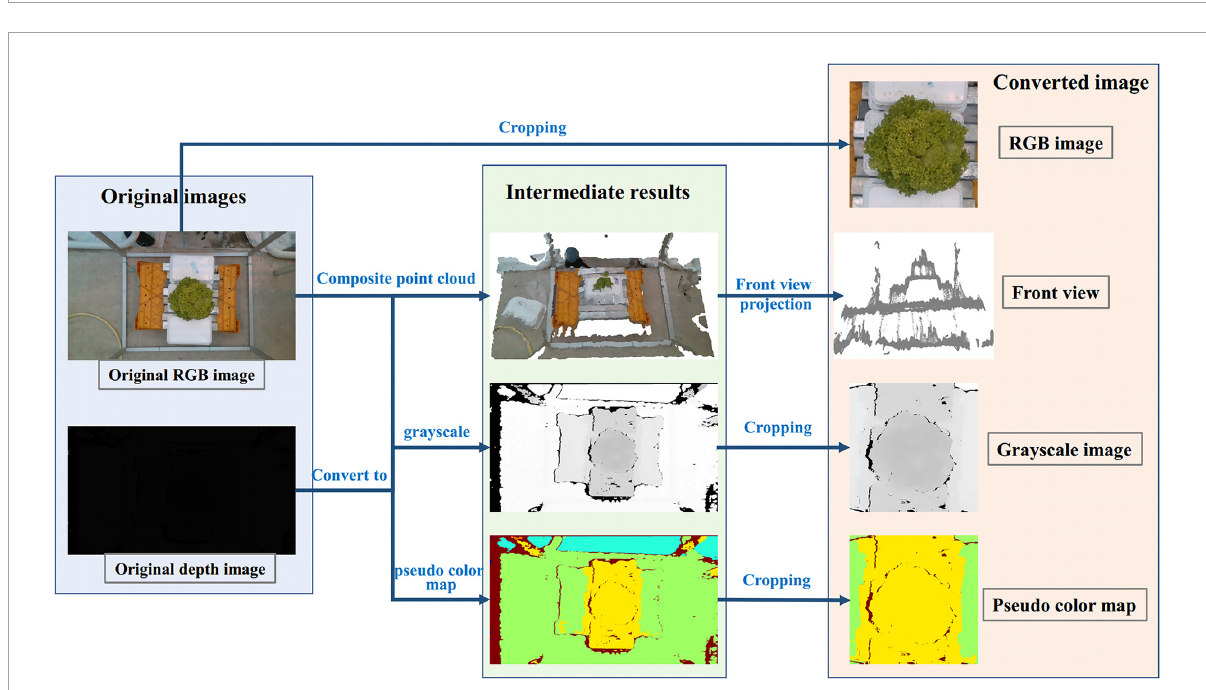
FIGURE10 Four different processing methods for estimating H. The first one is to estimate H with the cropped RGB image; The second is the front view estimation of H obtained from the point cloud projection synthesized by RGB and depth images; The third is to convert the depth image into the grayscale image; The fourth is to convert depth image into the pseudo color image. Among them, the fourth method to convert the depth image into the pseudo color image is the data processing method of TMSCNet for estimating H.